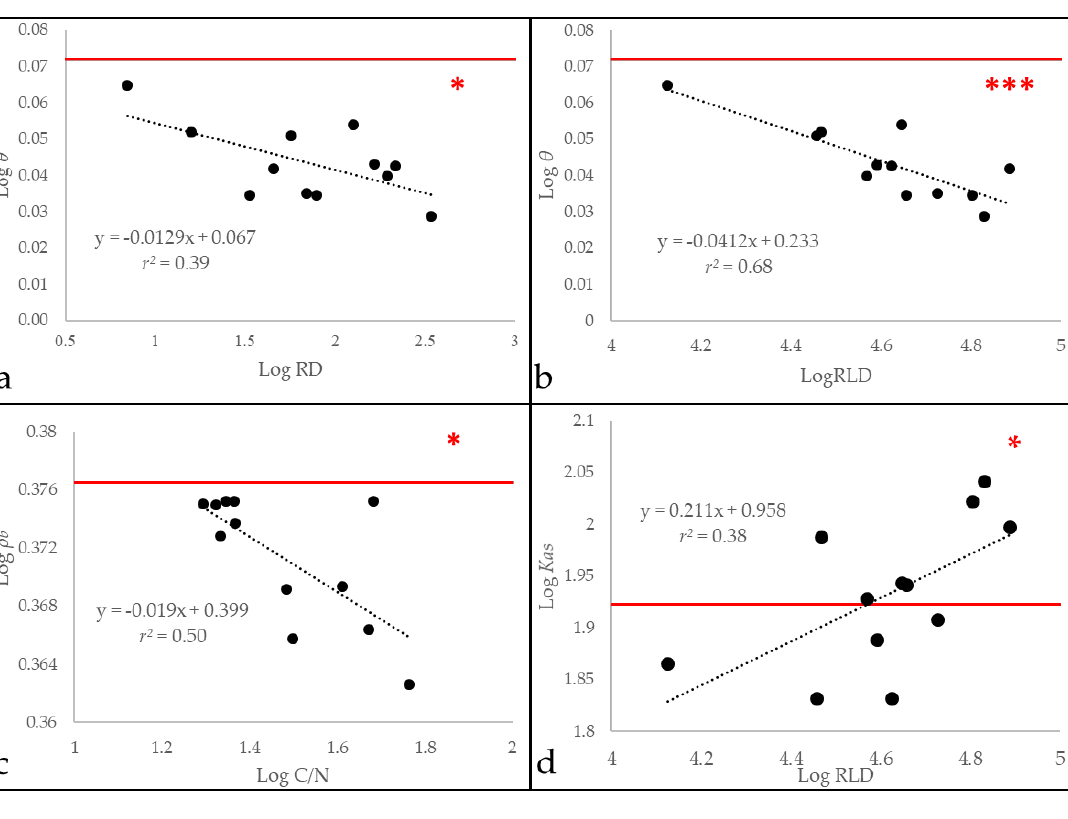
Figure 2. Relationships between root traits and soil properties. For each graph, the red line represents the mean value obtained in bare soil. Red stars represent the significance of each Pearson correlation with p -value > 0.05 = NS, p -value < 0.05 = *, p -value < 0.01 = **, and p -value < 0.001 = ***. ρ b = soil bulk density, C / N = Carbon / Nitrogen ratio, k as = specific air permeability, RMD = Root Mass Density, RLD = Root Length Density, θ = soil water content.